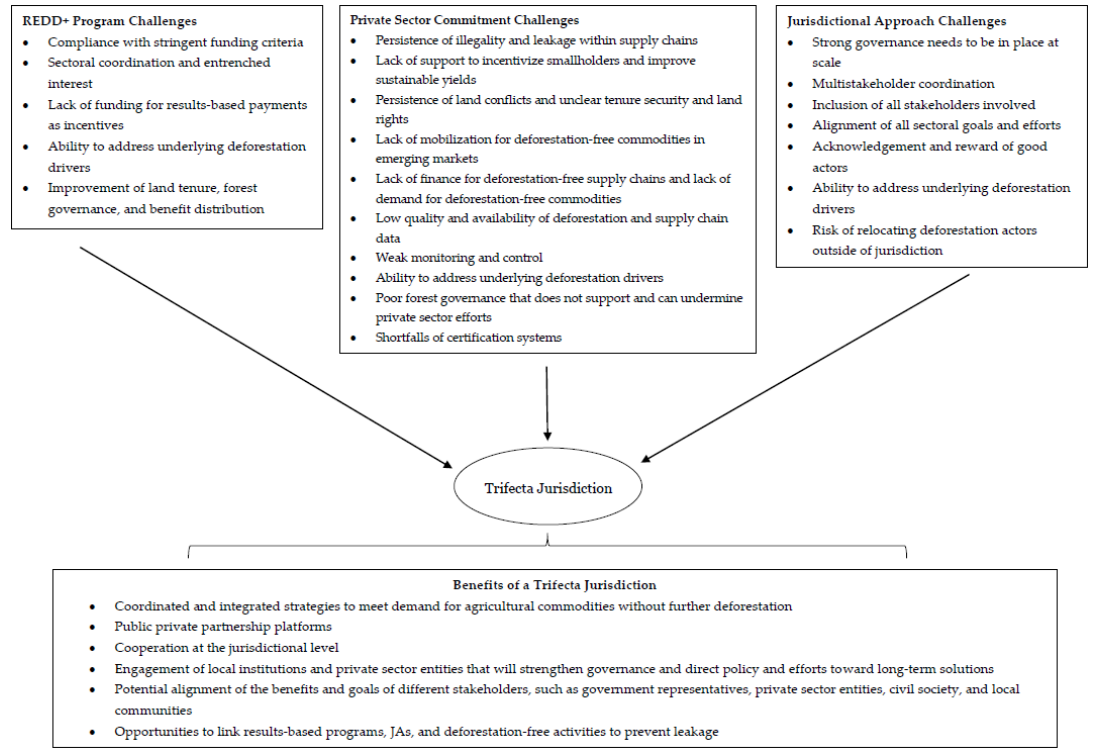
Figure 2. Element-specific challenges that can be overcome through collaboration in trifecta jurisdictions and the benefits such alignment can yield.